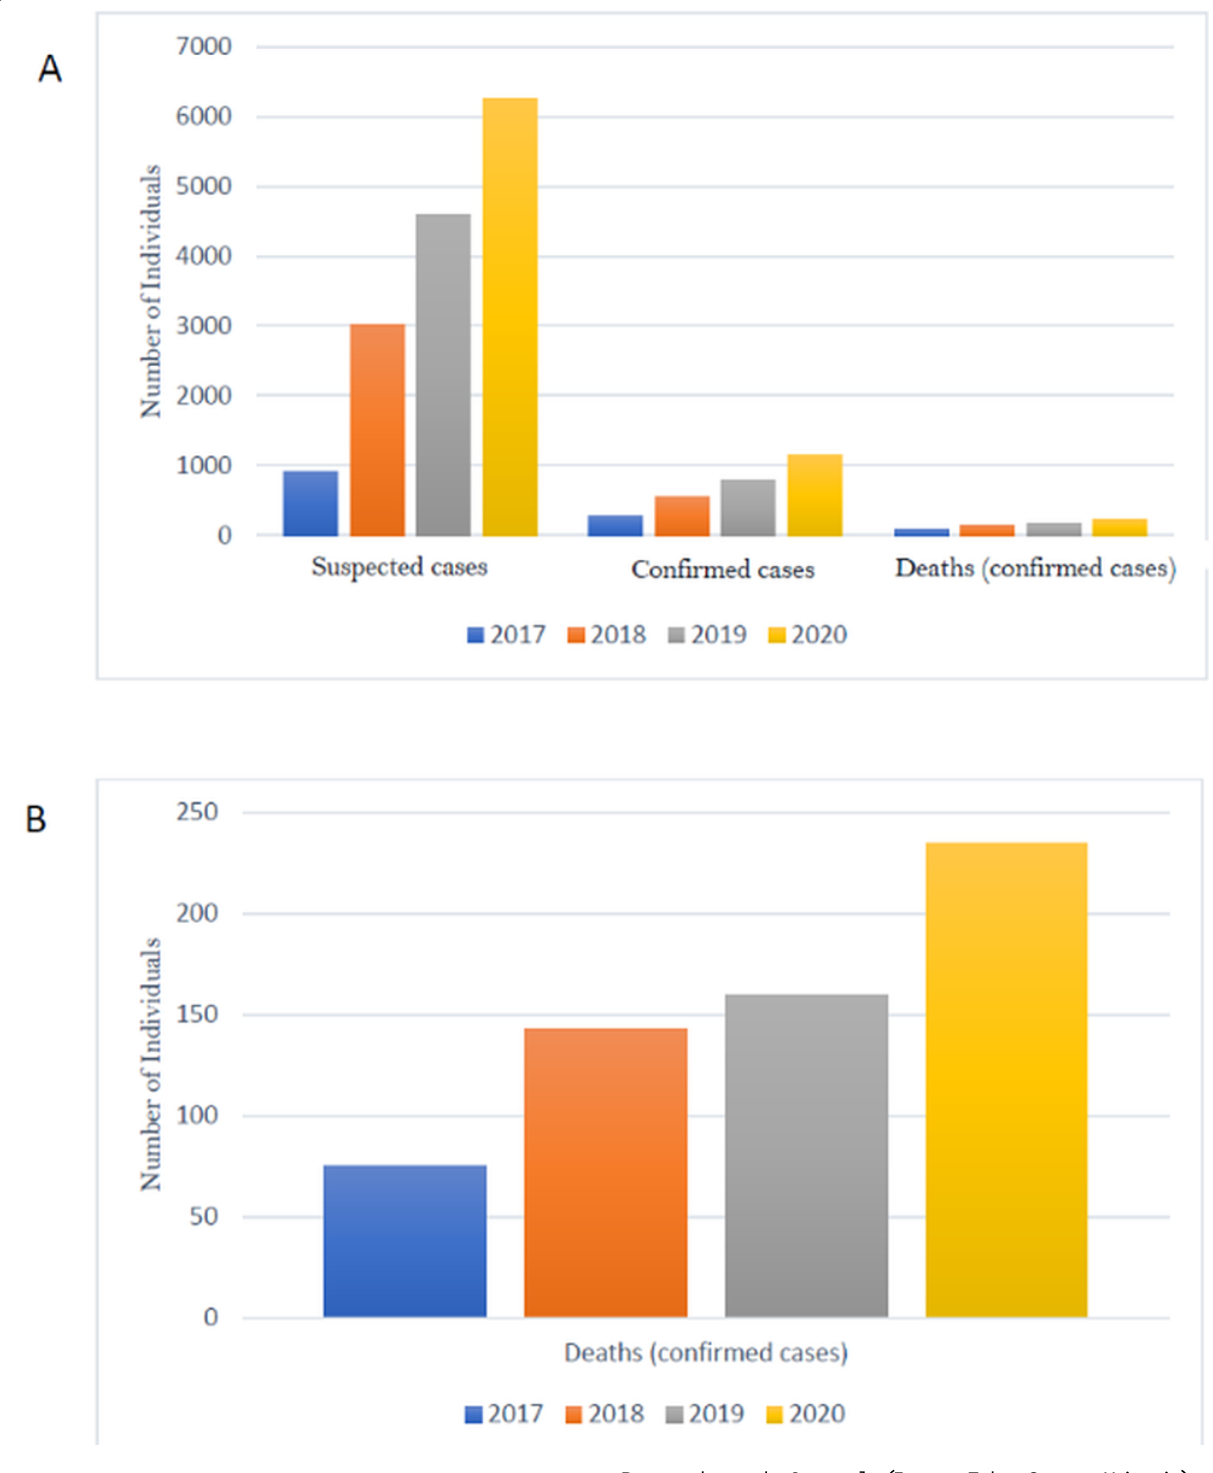
Figure 1. (A) Year-by-year trends in the epidemiology of Lassa fever in Nigeria showing total suspected cases, confirmed cases, and the death toll for confirmed cases as reported by the Nigerian Center for Disease Control as at week 46 of every year. (B) Confirmed deaths due to Lassa fever in Nigeria for period 2017 to